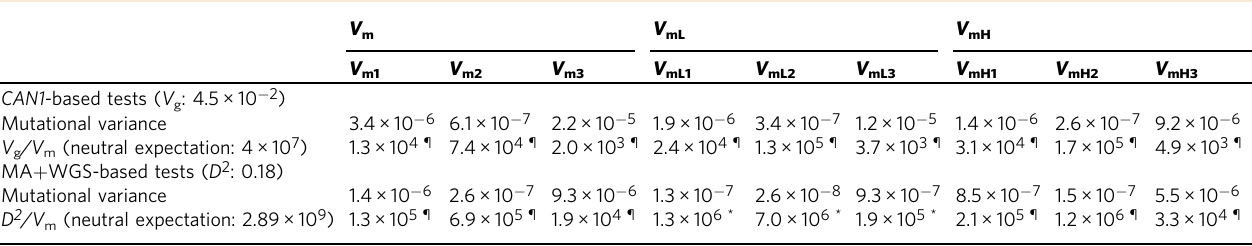
Table 1 Test of stabilizing selection of the mutation rate in yeast.